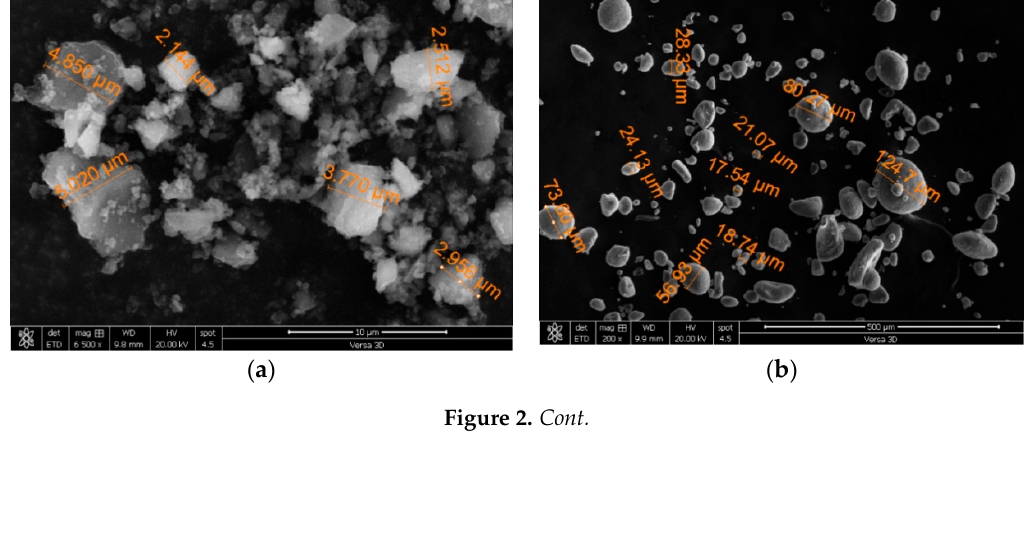
Figure 2. Scanning electron microscopy (SEM) images of fine materials. ( a ) Ultrafine (C); ( b ) Silica fume (S); ( c ) Cement. 2.2. Fine and Coarse Aggregates Two types of sands with different particle sizes were used for preparation of mixes named as crushed sand and fine sand. The Fineness moduli were 1.47 and 4.66 for fine and crushed sand, respectively. Fine and crushed siliceous sand were combined as 65% and 35%, respectively, to achieve a fineness modulus of 2.54. Coarse aggregate with maximum size of 10 mm was used for mix preparation. The physical properties of fine and coarse aggregate are summarized in Table 2. Particle size distributions of sands and coarse aggregate are shown in Figure 3 . Table 2. Physical properties of fine and coarse aggregate. Properties/Material